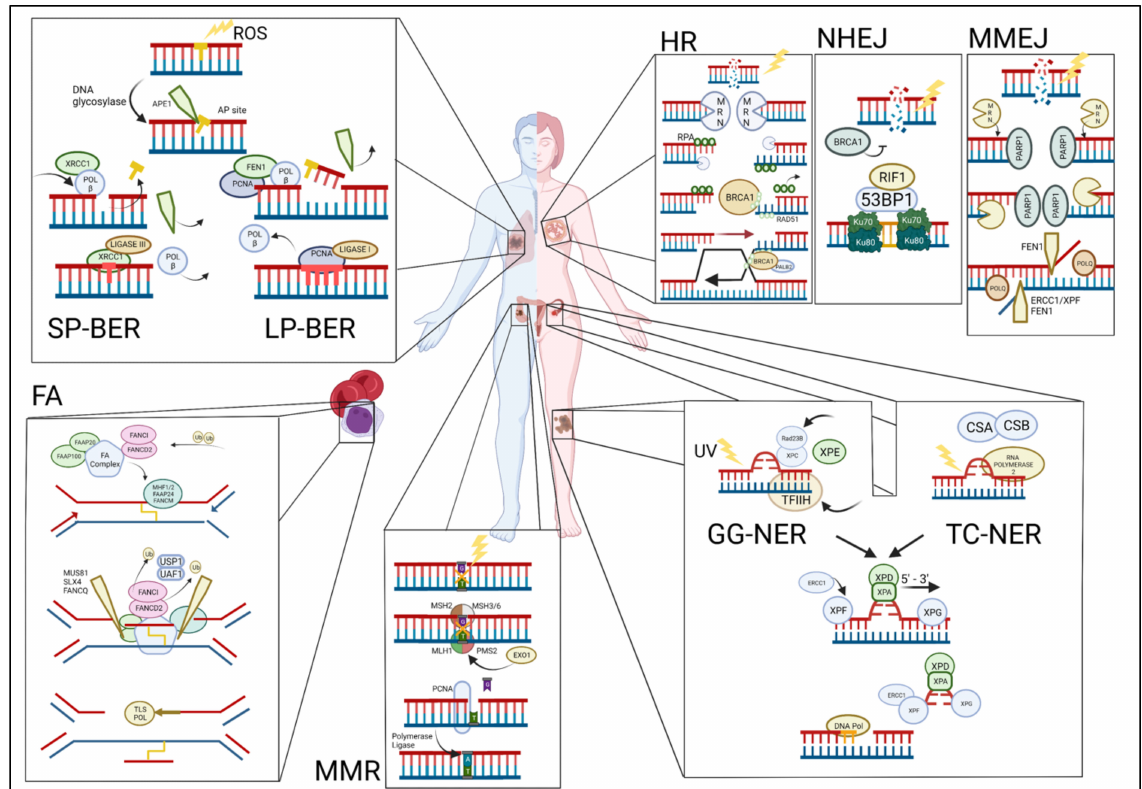
Figure 1. Overview of the DNA damage repair pathways and their commonly associated cancers (clockwise). TOP LEFT: Single-stranded breaks are repaired via either short-patch base excision repair (SP-BER) or long-patch BER (LP-BER). BER begins when the DNA base is damaged and is excised by the enzyme apurinic/apyrimidinic endodeoxyribonuclease 1 (APE1) and further processed by either SP-BER or LP-BER. Polymorphisms in BER pathway genes have been linked to an increased risk for the development of lung and other cancers. TOP RIGHT: Double-stranded breaks (DSBs) are repaired via homologous recombination (HR), non-homologous end joining (NHEJ), or microhomology- mediated end joining (MMEJ). HR: the MRE11-RAD50-NBS1 (MRN) complex detects double-stranded breaks. NHEJ: the Ku70/80 heterodimer detects and binds to the DSBs. MMEJ: the protein-coding gene poly (ADP-Ribose) polymerase 1 (PARP1) detects DSB mutations in HR pathway genes that are frequently associated with breast and other cancers. BOTTOM RIGHT: Nucleotide excision repair (NER) pathway is activated upon the detection of bulky DNA lesions and starts off as either a global genome NER (GG-NER) or a transcription-coupled NER (TC-NER). Mutations in TC-NER proteins have been identified in a subset of ovarian cancers, conferring increased sensitivity to platinum-based chemotherapy. BOTTOM MIDDLE: Mismatched repair (MMR) pathway is initiated by recruitment and binding of the MutL α complex on the damaged site. Mutations in MMR pathway genes are associated with colorectal and other cancers. BOTTOM LEFT: In the Fanconi anemia (FA) pathway, FANCM is first recruited to the site of ICL damage at the stalled replication fork along with FAAP24 and the heterodimer MHF1/2, followed by HR pathway mutations in FA pathway genes that lead to the Fanconi anemia syndrome characterized by a high incidence of childhood